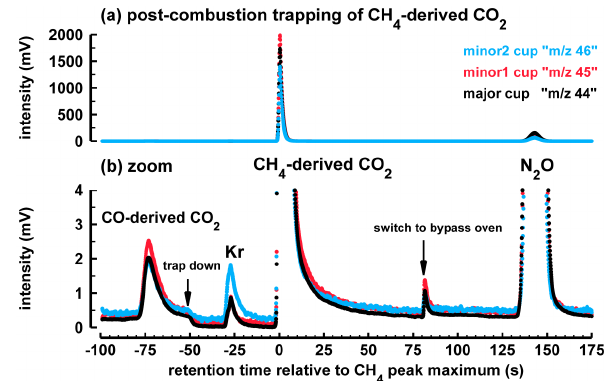
Fig. 9. Chromatogram showing the separation of Kr from CH 4 –derived CO 2 achieved with the improved IMAU system, which includes a GC column after the combustion oven. Due to the additional GC, Kr elutes before instead of after the CH 4 -derived CO 2 peak as shown in the chromatograms of Fig. 3.